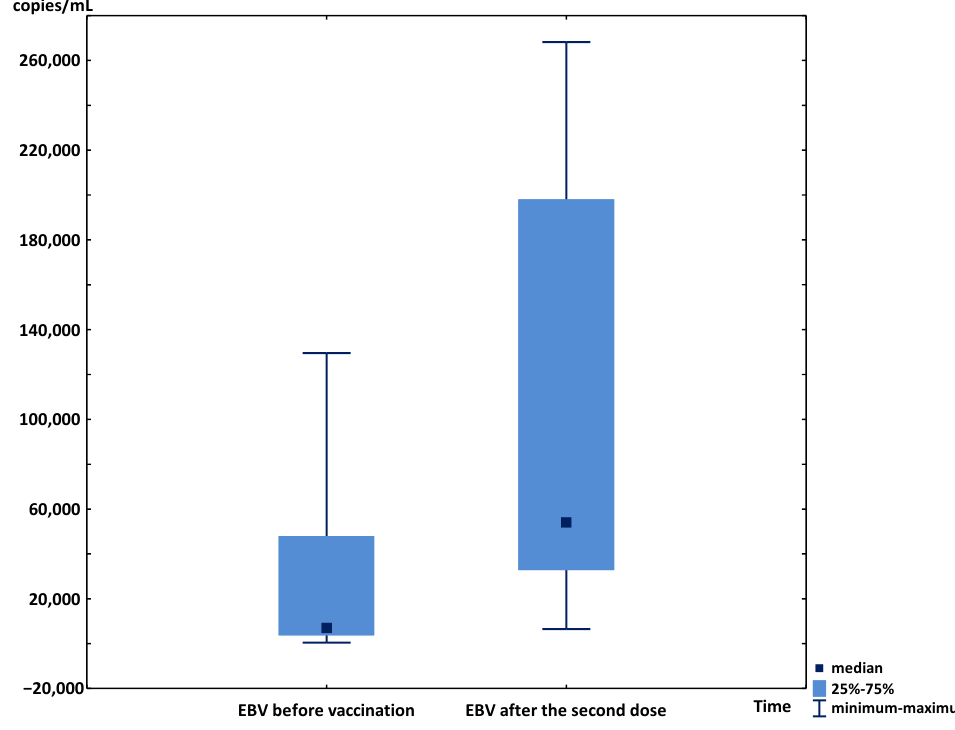
Figure 1. Median, minimum, maximum, and interquartile ranges of EBV viremia before the vaccina- tion and after the second dose of SARS-CoV-2 vaccine in transplant patients.